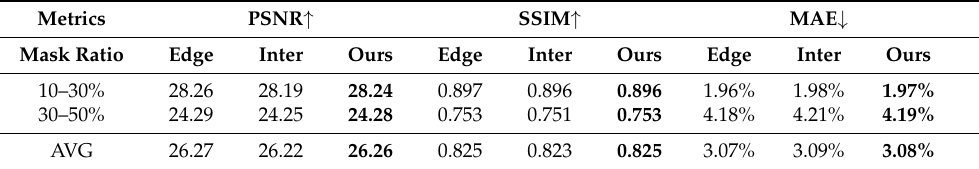
Table 8. Position analysis of our Ada-attention on the AID dataset.